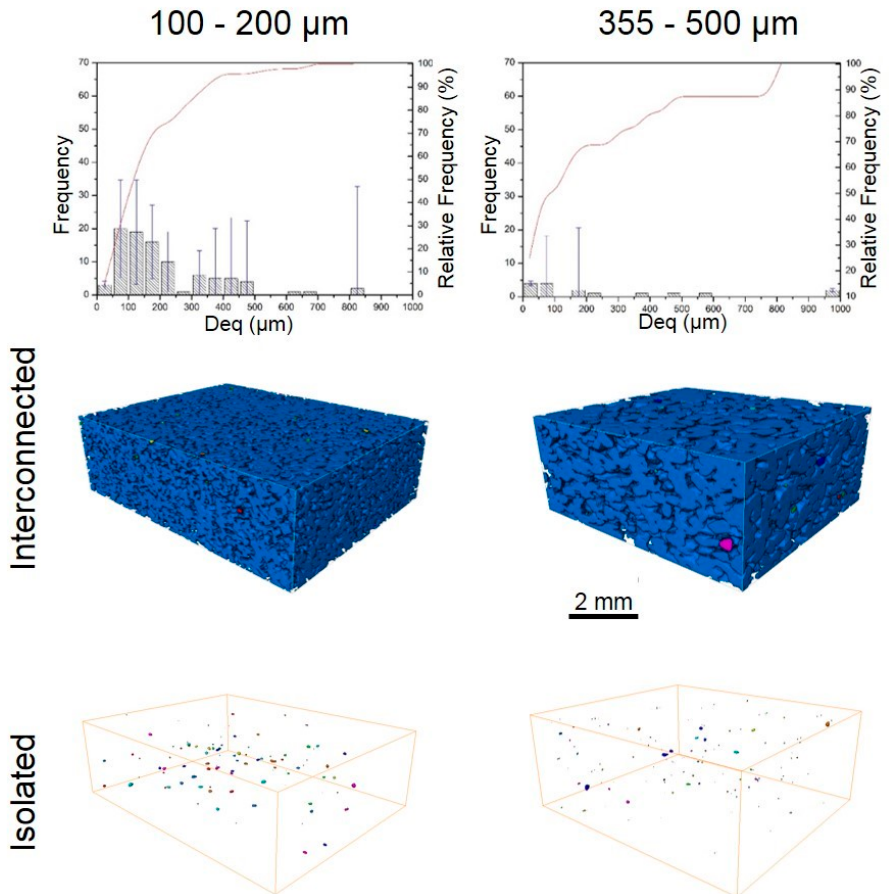
Figure 4. Equivalent diameter determined and interconnected and isolated porosity analyzed by M-CT for two di ff erent ranges of spacer particles size: 100 − 200 μ m and 355 − 500 μ m.